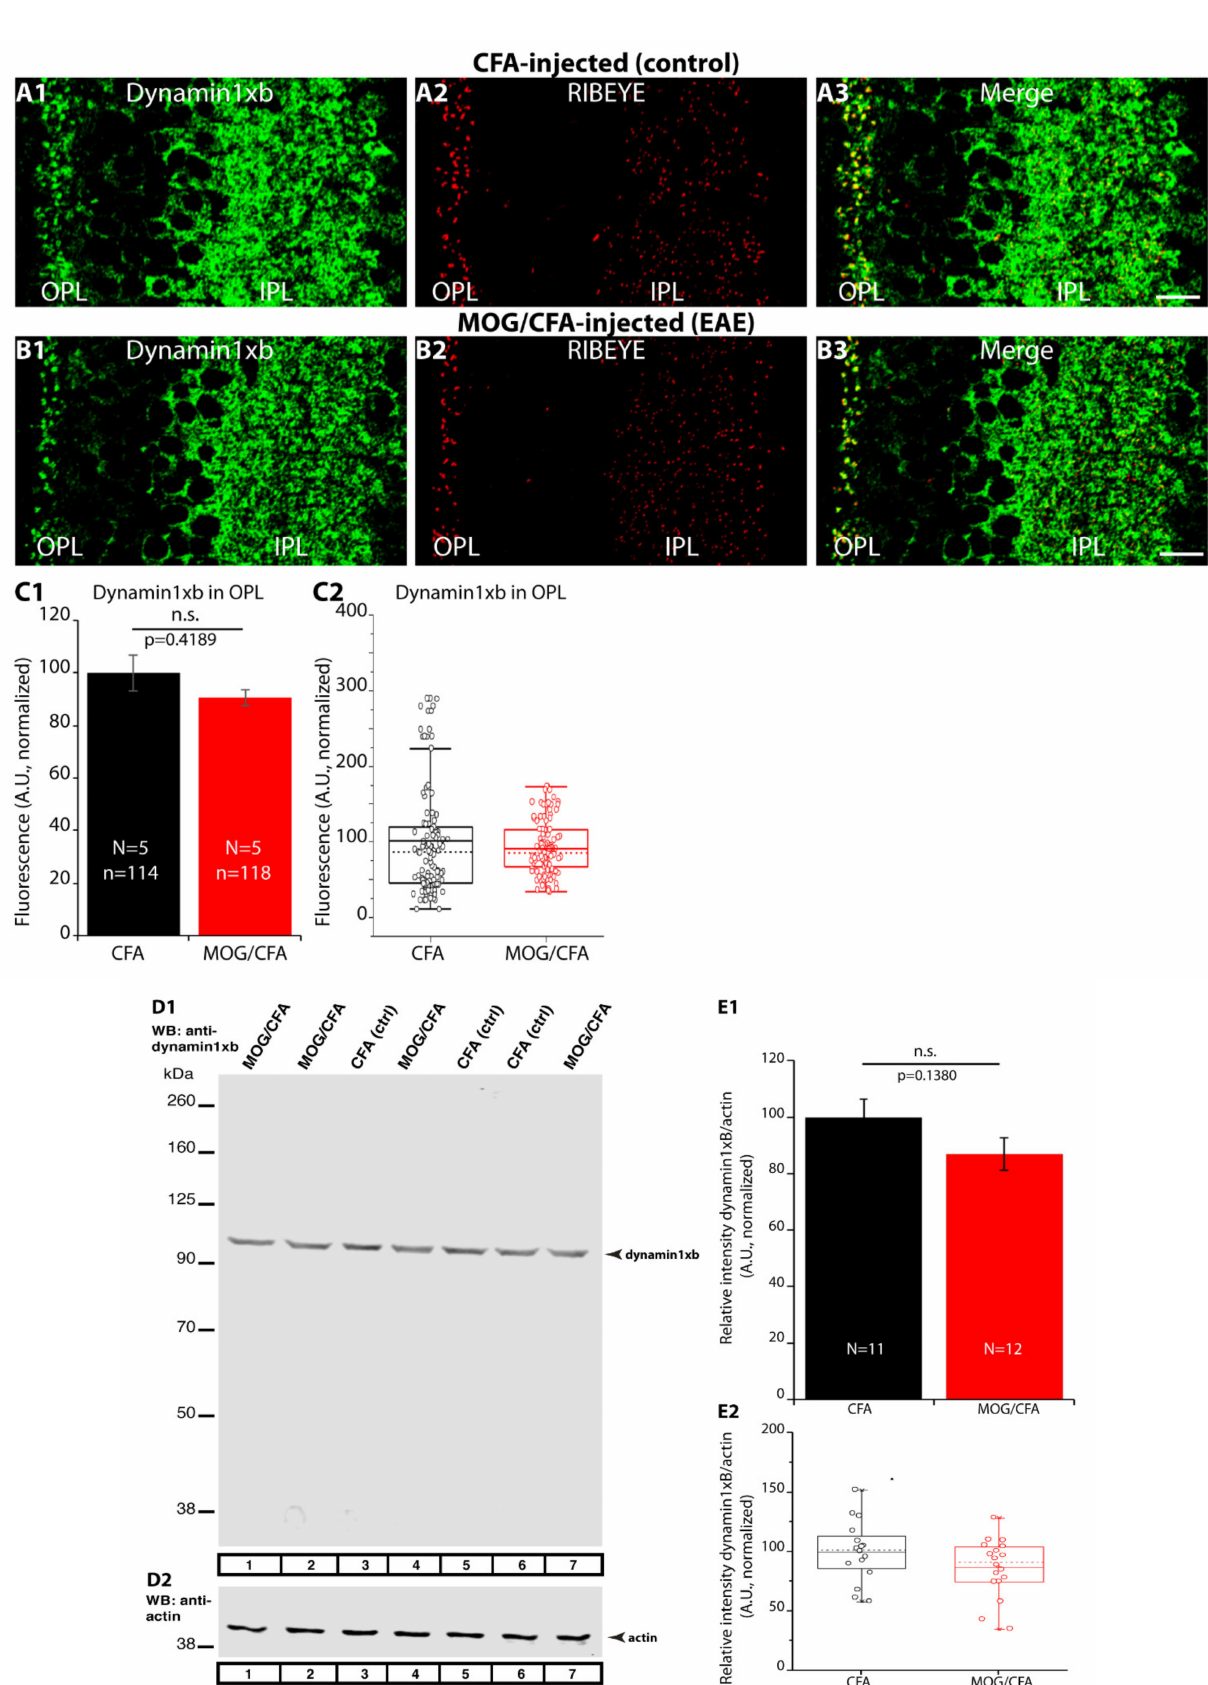
Figure 11. Dynamin1xb expression in the OPL does not differ between MOG/CFA-injected EAE mice and CFA-injected control mice. ( A1 – B3 ) Retina sections (0.5 µ m thickness) from CFA- and MOG/CFA-injected mice retina obtained on day